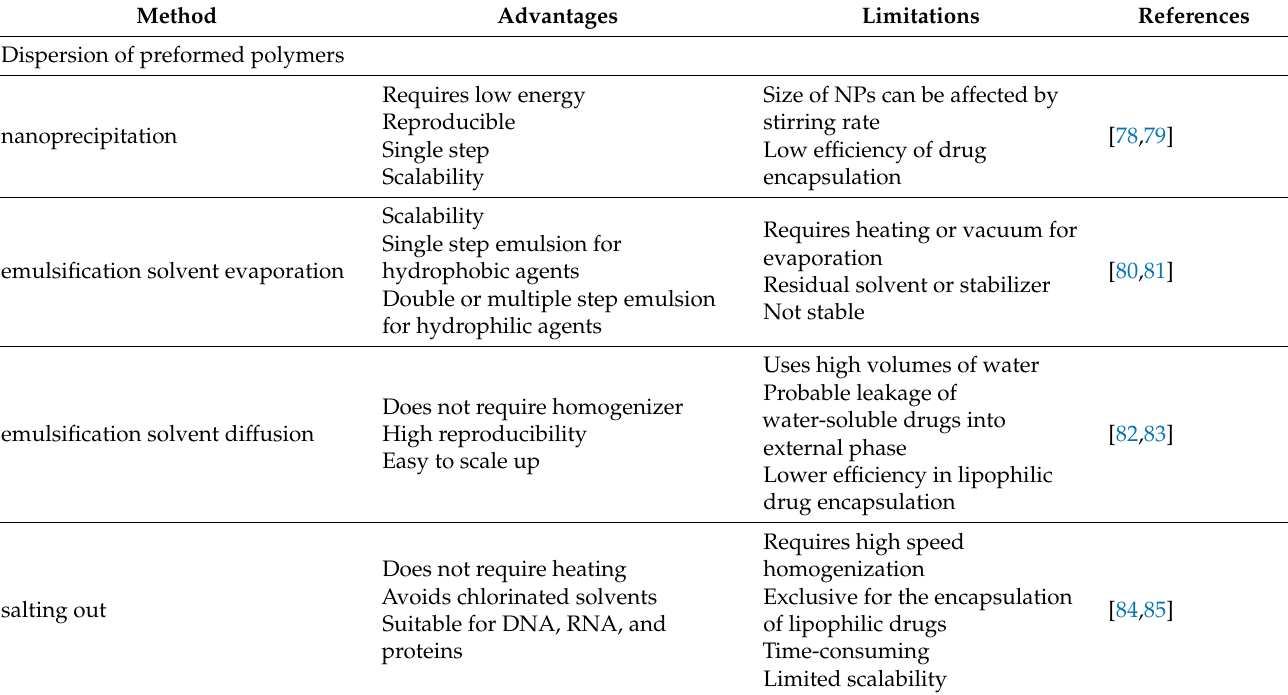
Table 1. Advantages and limitations of two types of polymer synthesis methods; dispersion of preformed polymer and direct